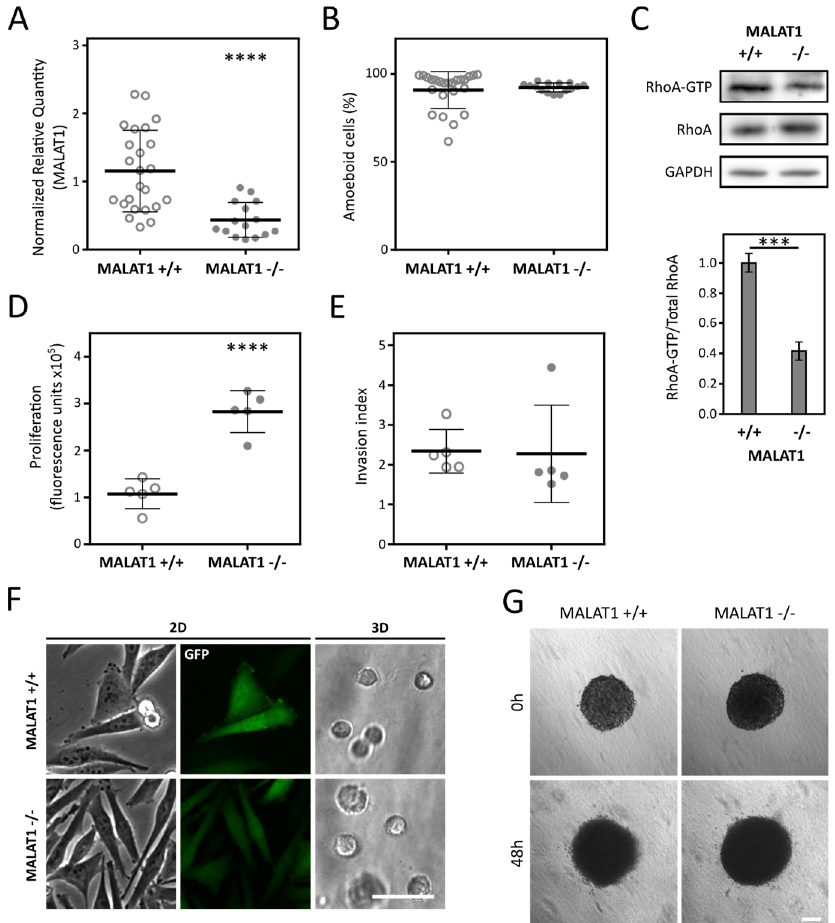
Figure 4. MALAT1 level and morphology of clones derived from the A2058 cell line. ( A ) RT-qPCR analysis of the MALAT1 gene expression in A2058-derived clones. Data represent the mean ± SD. ( B ) Quantification of clones’ morphology in 3D collagen. Data represent the mean ± SD. N(MALAT1+/+) = 24 clones; N(MALAT1 − / − ) = 15 clones. ( C ) Pull-down of active RhoA from 3D samples of pooled clones. Representative immunoblots are in upper part, lower part represents the densitometry quantification. Data represent the mean ± SEM. ( D ) Proliferation of selected clones in 3D collagen. Data represent mean fluorescence of AlamarBlue ± SD. ( E ) Quantification of cell invasion from spheroids. Data represent the mean ± SD. ( F ) Representative images of MALAT1+/+ and MALAT1 − / − clones in 2D environment (Petri dish) and in 3D collagen matrix. ( G ) Representative images of invasion of control and heterozygous MALAT1 clones from spheroids. p -values: **** p < 0.0001, *** p < 0.001, Scale bar 50 μ m in part F and 150 μ m in part G.